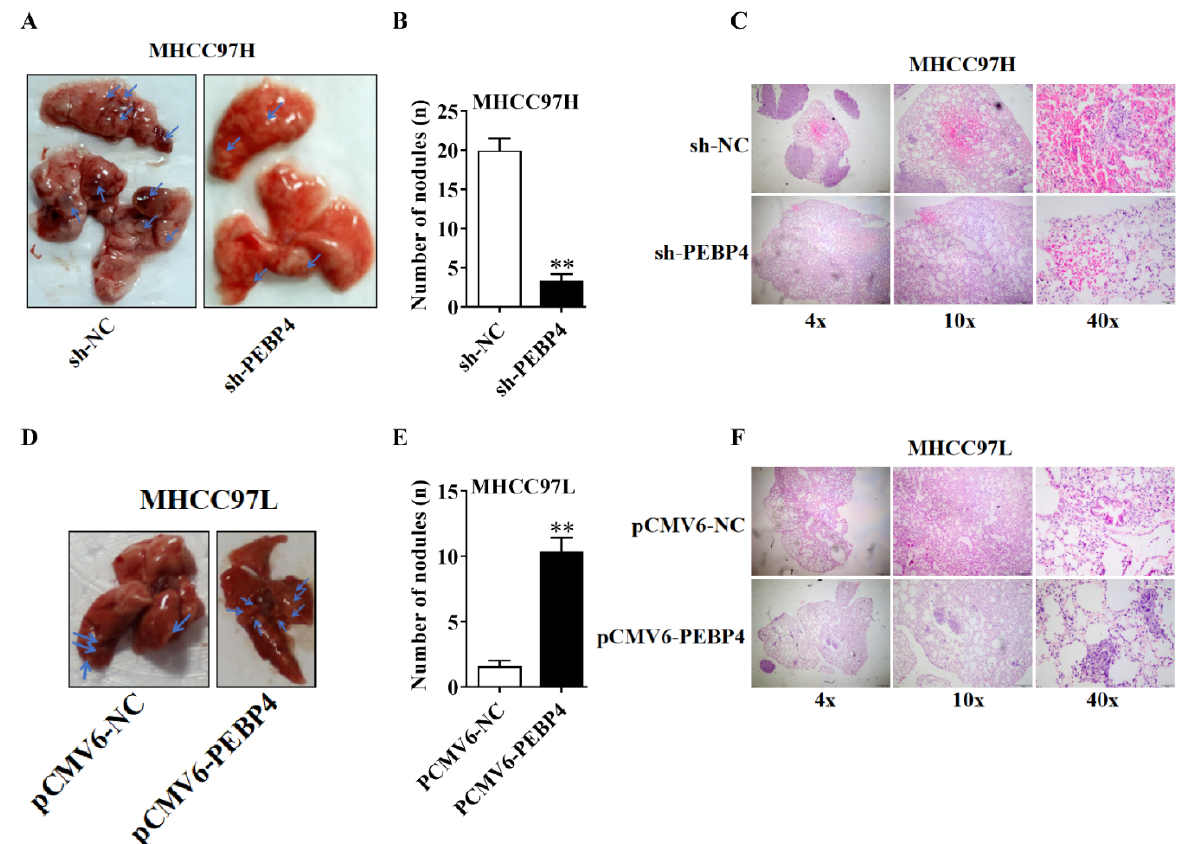
Figure 7. The role of PEBP4 in regulation of metastasis of HCC. ( A – C ) MHCC97H/sh-NC or MHCC97H/sh-PEBP4 cells were injected into tail veins of nude mice (n = 5/group) and 10 weeks later, lungs were dissected and photographed. The representative images of lung appearance were shown ( A ). The metastatic nodules in the lung were counted and plotted ( B ). Representative hema- toxylin and eosin (H&E) stained images of the lung were shown (magnification: ×40, ×100, ×400) ( C ). ( D – F ). MHCC97L/pCMV6-PEBP4 and MHCC97L/pCMV6-NC cells were injected, and lung metas- tasis was assessed similarly to ( A – C ). Arrows point to metastatic nodules. Data were presented as mean ± SEM (n = 5), ** p < 0.01.